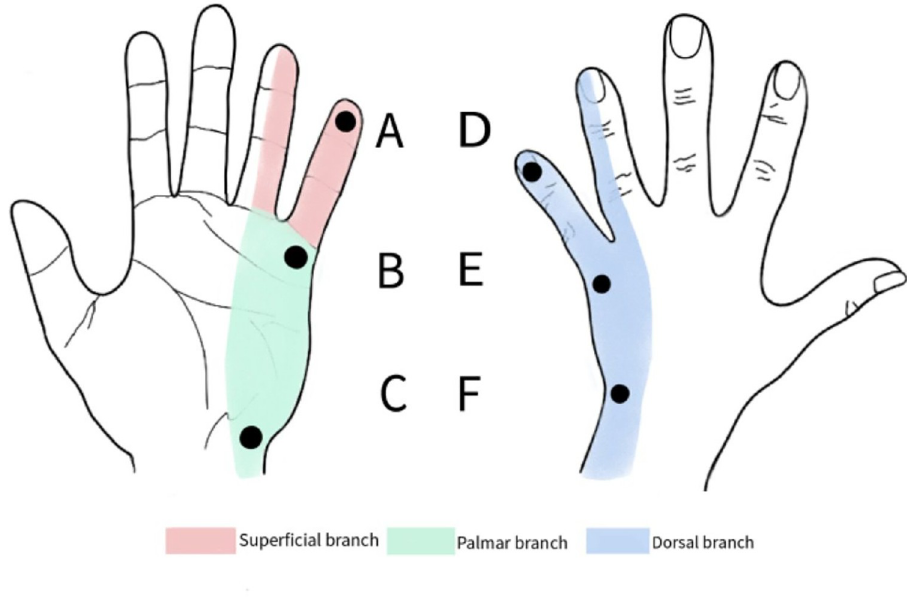
Fig 1. Sensory testing